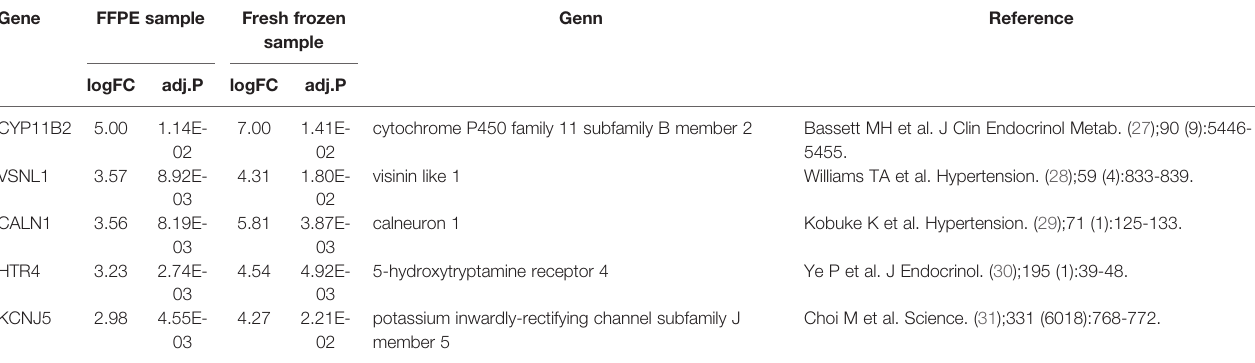
Showing genes related to APA. The higher the logFC, the higher the expression in APA than